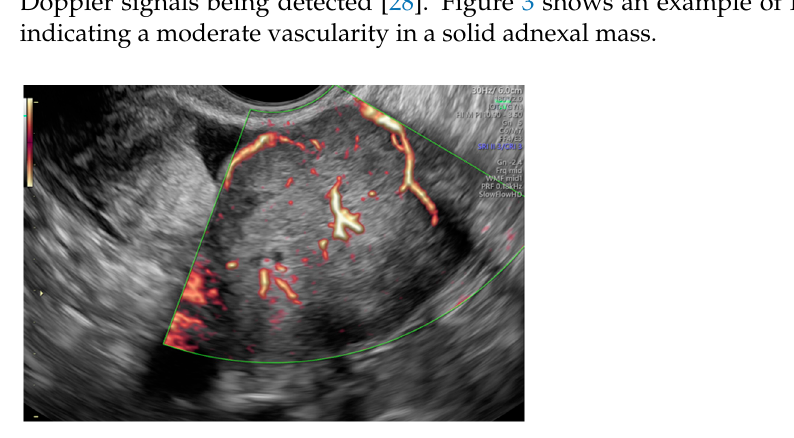
Figure 3. Moderate vascularity of a small solid ovarian mass reflecting the IOTA color score of 3. Final histology: Sertoli–Leydig tumor.